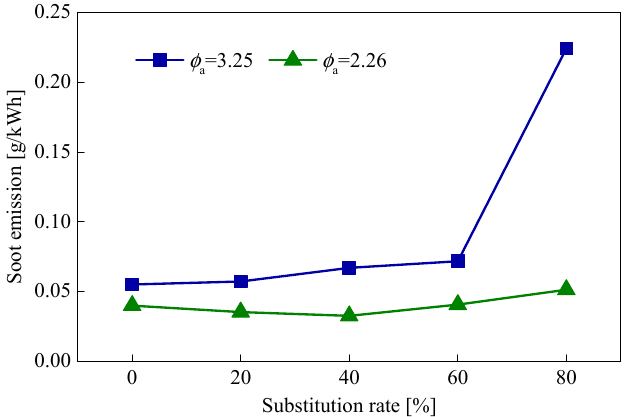
Figure 10. Comparison of soot emissions with different substitution rates.